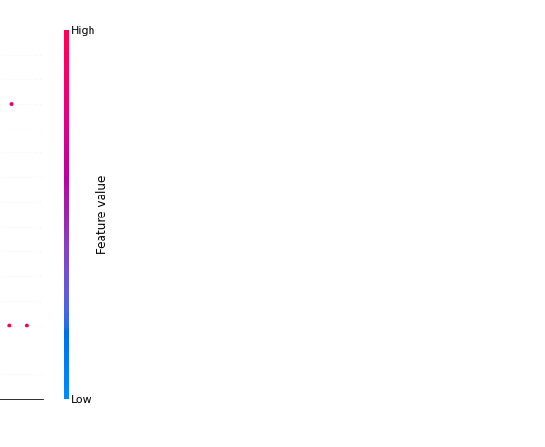
Figure 6. Summary plot per body parts for test data. The x-axis indicates the changing amount to the SHAP value by top effective factors. Such factors are arranged in descending order from top to bottom based on their impact on the y-axis.